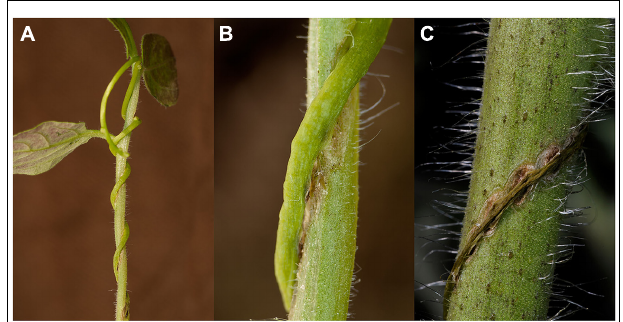
FIGURE 2 | Cuscuta reflexa on its resistant host plant Solanum lycopersicum (cultivated tomato). (A) C. reflexa ∼ 7 days after initial contact to the tomato shoot. (B) Enlarged detail of (A) shows the secondarily modified tissue of tomato at the penetration sites next to the parasitic haustoria. (C) C. reflexa dies off ∼ 14 days after initial contact with tomato; the secondarily modified tissue of tomato reminds of a kind of ‘hypersensitive response’